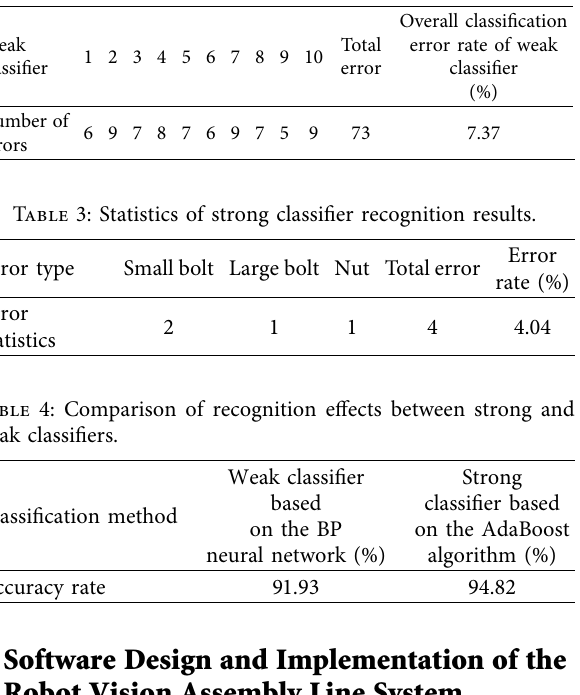
Table 2: Statistics of recognition results of multiple weak classifers.